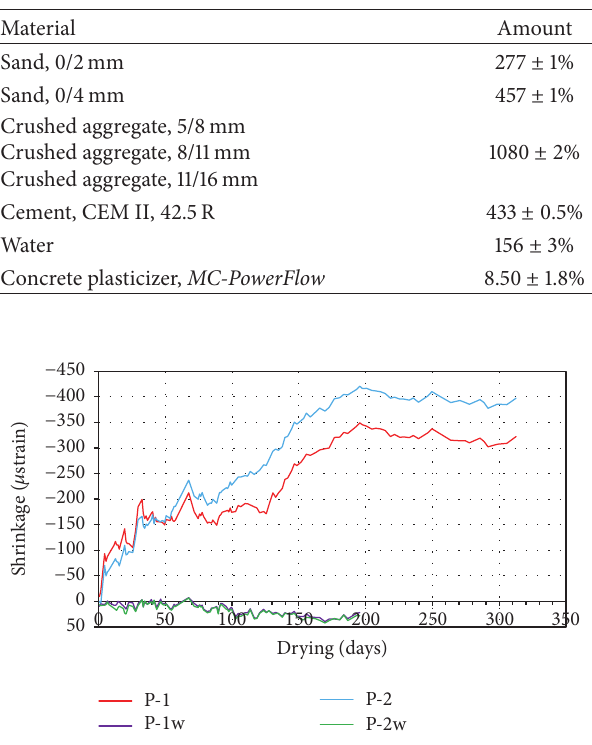
Figure 2: Development of concrete shrinkage.